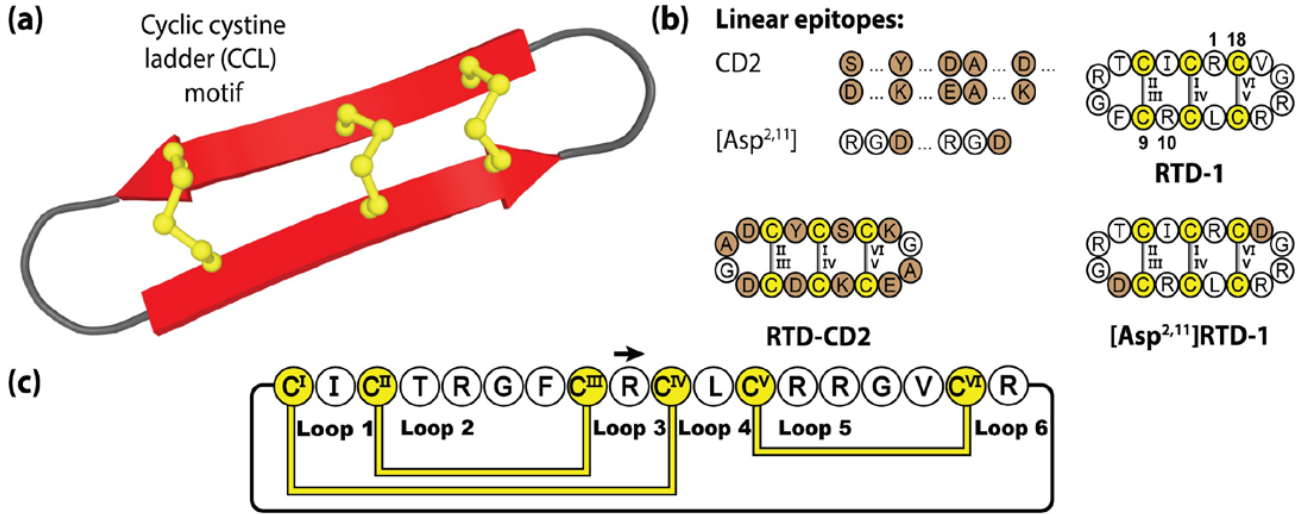
Figure 5. Structure and sequence of the θ-defensin RTD-1 and two grafted examples. ( a ) Three- dimensional structure of RTD-1. ( b ) Peptide sequences of RTD-1 and two engineered variants. ( c ) Amino acid sequence, disulfide bond connectivity and loop nomenclature of RTD-1. Cysteine residues are numbered and highlighted in yellow, with engineered epitope sequences represented by brown shading.